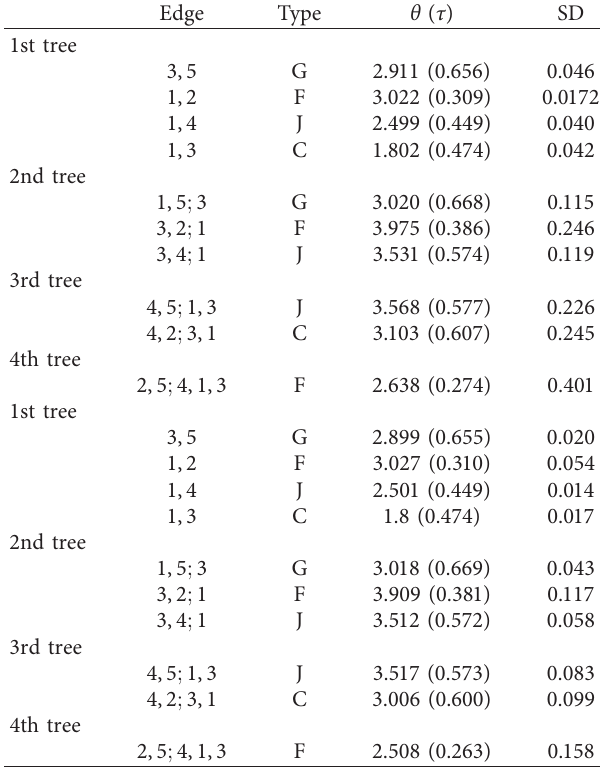
Table 5: Summary of the estimation results of the mixture of R- vine density model fitted to nonmixture simulated datasets for the simulated data of size 300 and